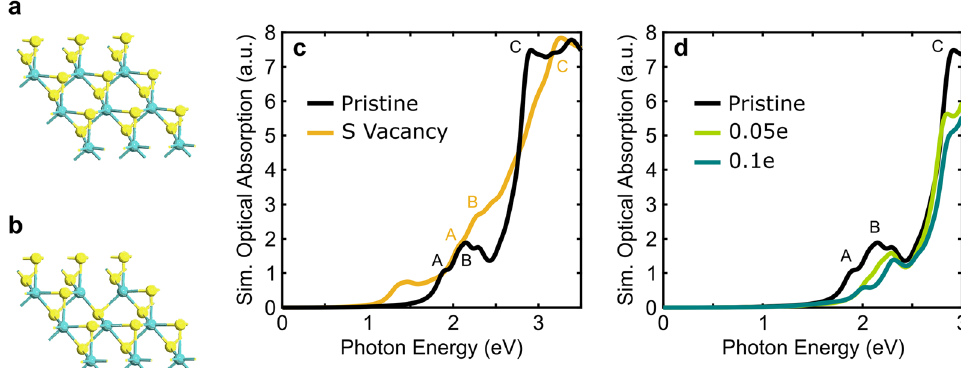
Fig. 7 Theoretical calculation of pristine, S-vacancy defect, and p-doped MoS 2 optical absorption spectra. Representative supercells for a pristine MoS 2 and b MoS 2 with a S-vacancy (cyan = Mo and yellow = S). c G 0 W 0 -BSE-SOC optical absorption spectra for pristine monolayer MoS 2 and having a S-vacancy. d G 0 W 0 -BSE-SOC optical absorption spectra for pristine monolayer MoS 2 upon removing 0.05e electrons and 0.1e electrons — illustrative of generalized p-doping